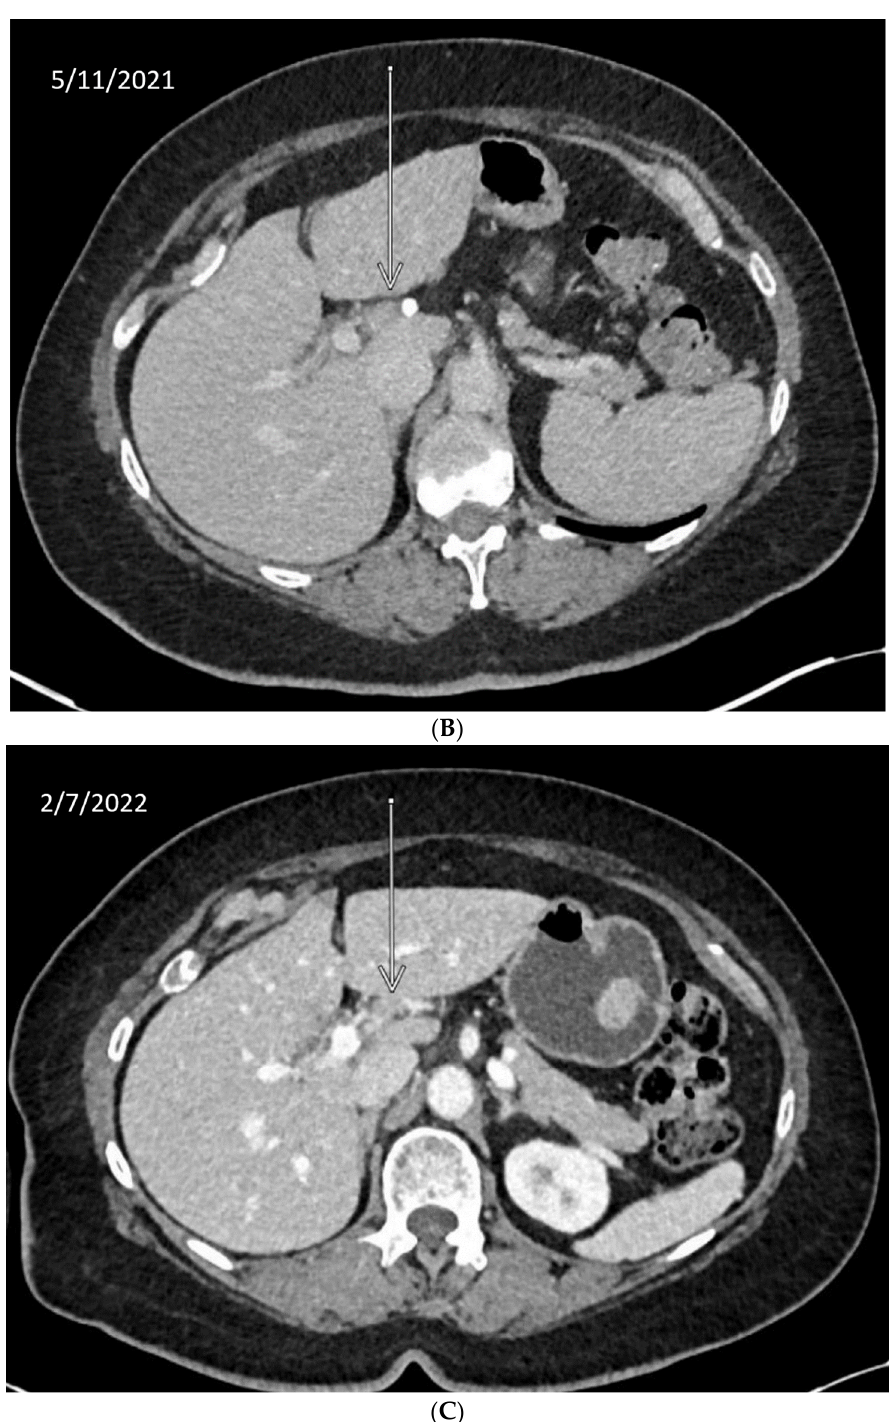
Figure 2. Time-lapsed CT images of a patient with intrahepatic CCA and RAD 51C mutation (via t(13;17) translocation with the chromosome 17 breakpoint identified in intron 4 of RAD 51C). She concurrently had a genomic loss of heterozygosity (gLOH) of 11%. The patient had an excellent response to treatment with PARPi and ICI and a 65% decrease in index lesion (shown by arrow). (A) CT from February 11, 2021. (B) CT from May 11, 2021. (C) CT from 7 February 2022.